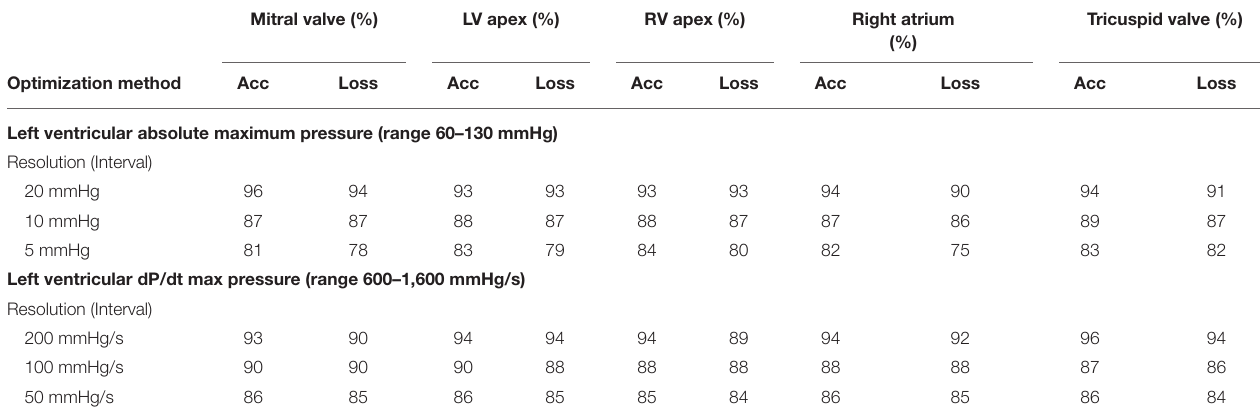
TABLE 2 | Accuracies for estimating LVP and LV dP/dtmax at different levels of resolution and for all sensor locations.